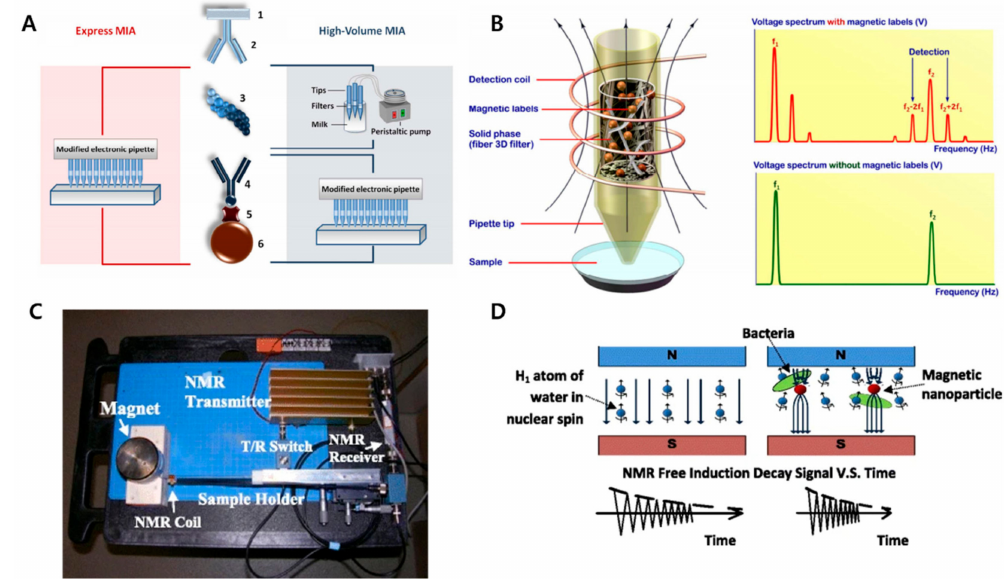
Figure 6. ( A ) Illustration of magnetic immunosandwich on 3D fiber filters used as a solid